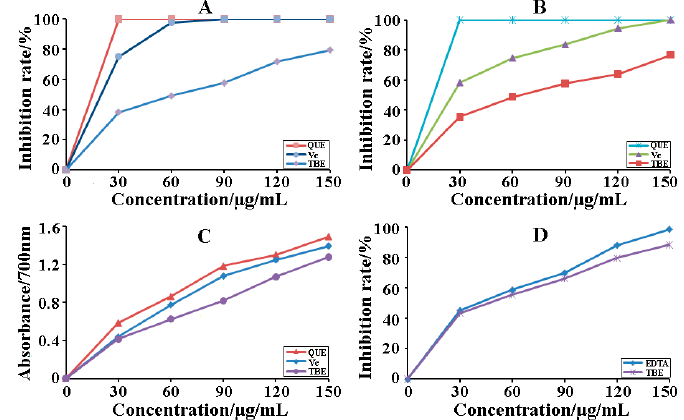
Figure 7. Antioxidant effects of TBE. ( A ) ABTS radical scavenging ability; ( B ) DPPH radical scavenging ability; ( C ) reducing power; ( D ) ferric chelation power.